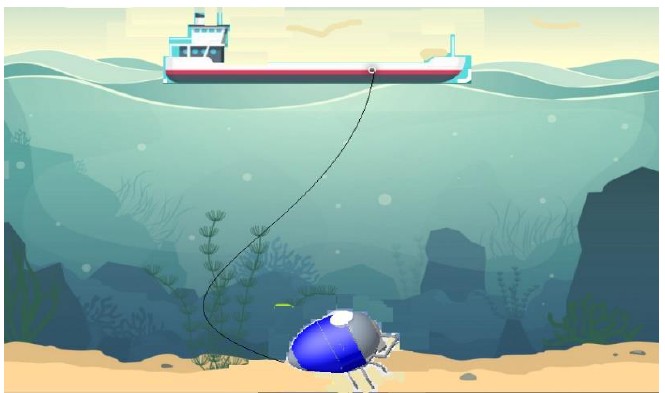
Figure 3. Operation concept of UMSWR.